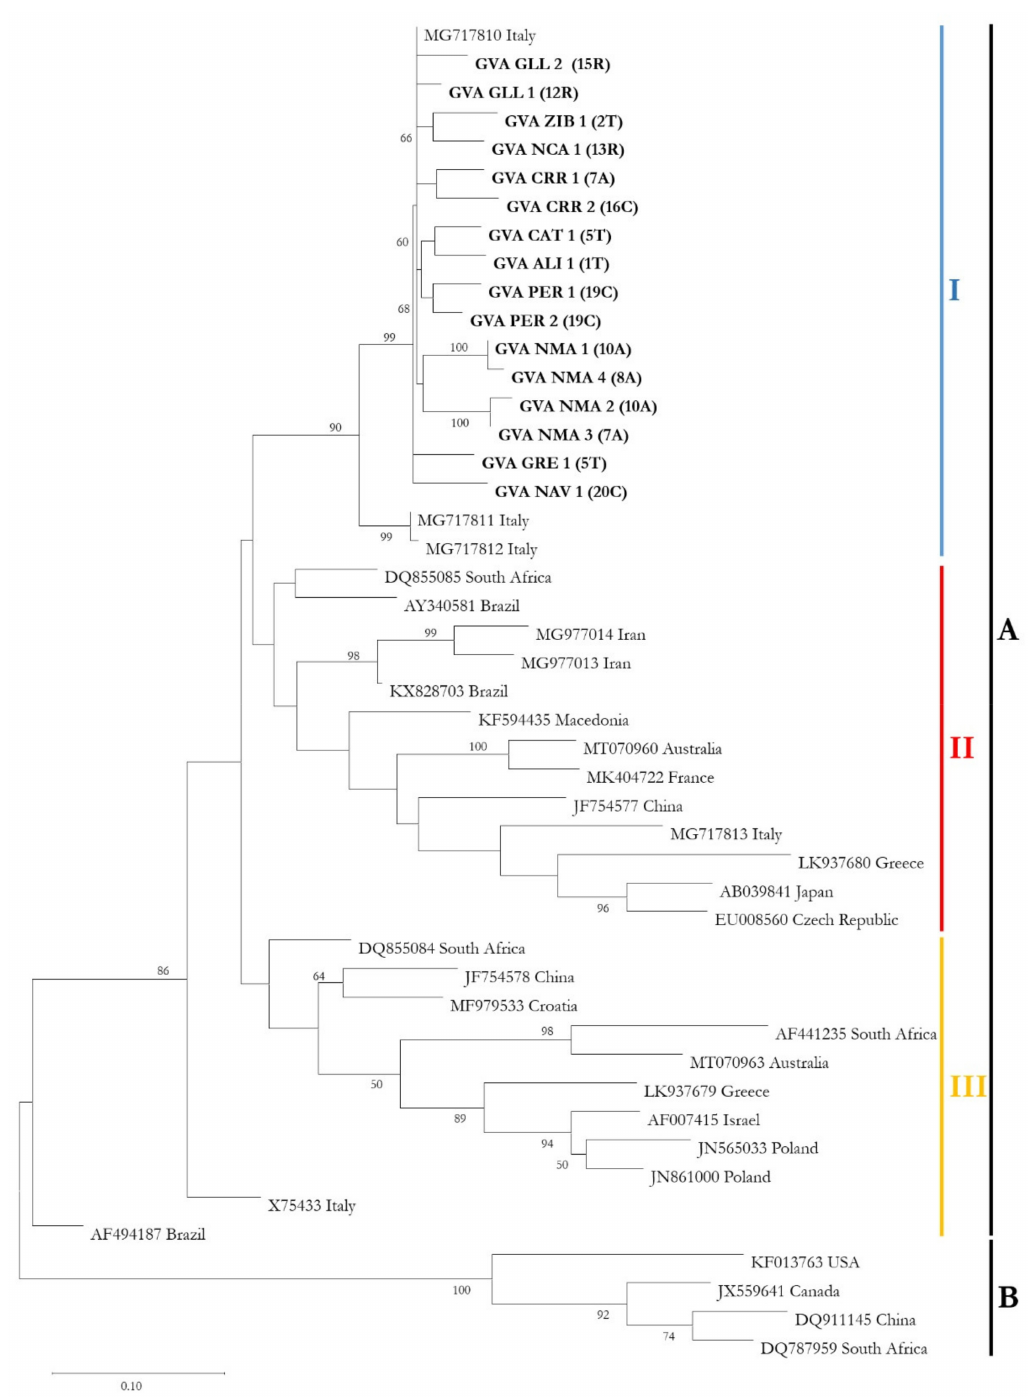
Figure 1. Phylogenetic relationships between coat protein genes of Italian Grapevine virus A (GVA) isolates (16 Sicilian sequences obtained in the present work; 5 Italian isolates retrieved from GenBank) and isolates from other countries. The evolutionary history was inferred by using the maximum- likelihood method (ML) based on the Kimura 2-parameter model (K2) with bootstraps of 1000 repli- cations, conducted with MEGA X program. Only bootstrap values ≥ 50% are indicated in the nodes. The sequences obtained in the present work are in bold. In brackets, the vineyard ID of origin (reported in Table 3). ‘A’ and ‘B’ letters indicate the two clusters obtained, while ‘I’, ‘II’ and ‘III’ indicate the three subclades within the cluster